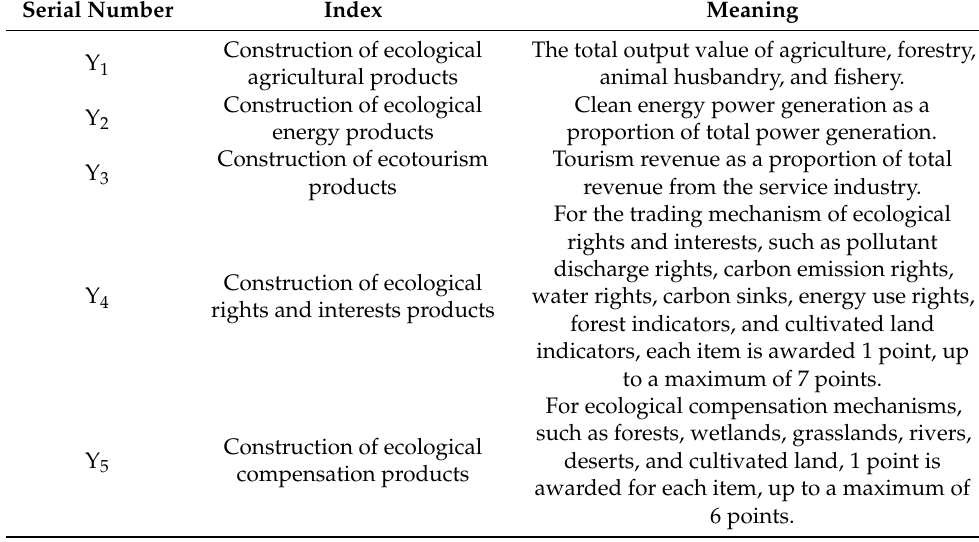
Table 4. Indicators and index interpretation of the EPV transformation subindex.